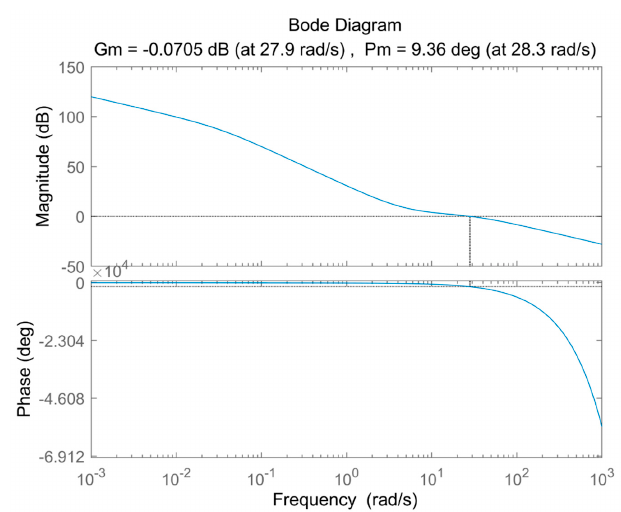
Figure 12. Result of Bode plot.